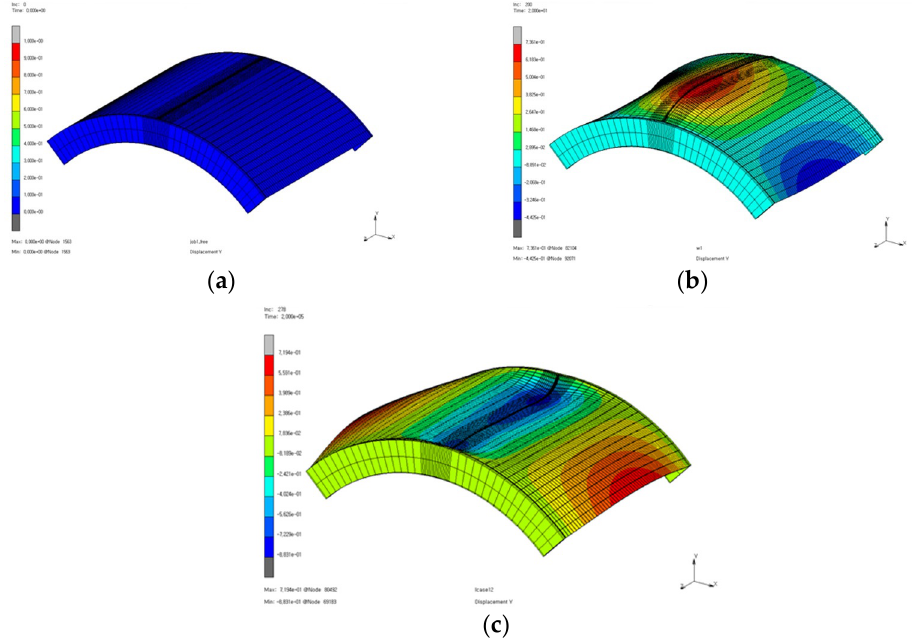
Figure 13. Welding deformation at tensile stress of 0 MPa: ( a ) initial conditions; ( b ) welding; ( c ) cooling after welding.